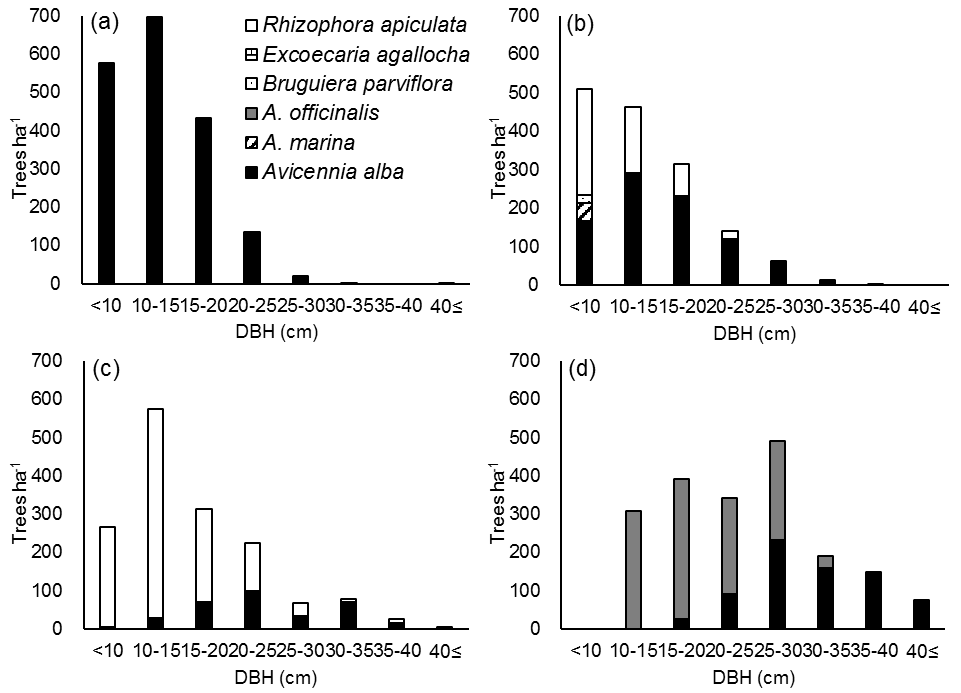
Figure 4. Diameter at breast height (DBH) distribution of trees ≥ 6 cm DBH by species for groups ( a ) A1, ( b ) A2, ( c ) A3, and ( d ) A4 in accretion sites. Plots belonging to each group are shown in Figure 2.